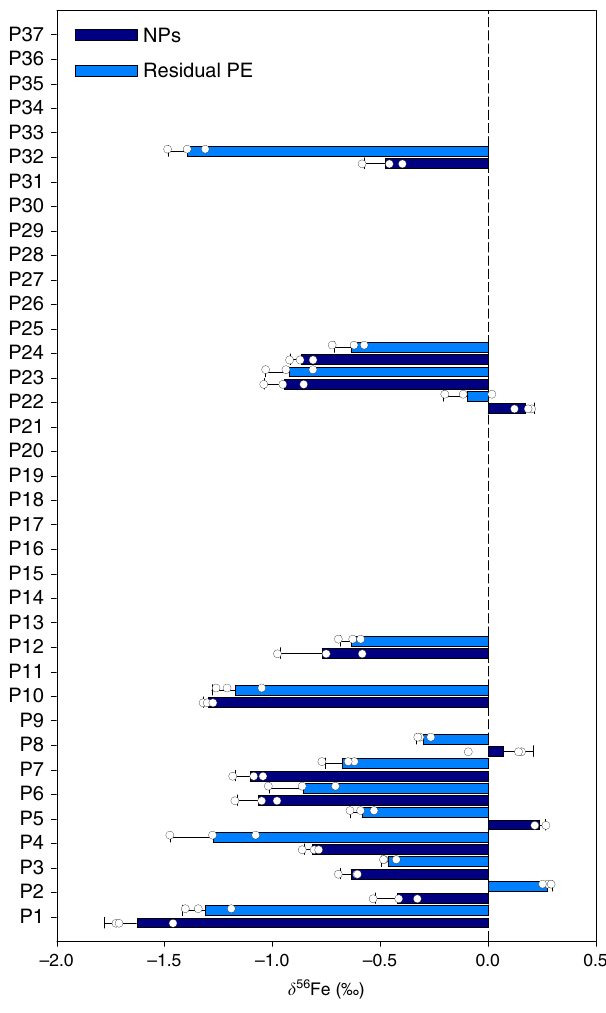
Fig. 4 Stable Fe isotopic fi ngerprints of human PE samples and the NPs extracted from the PE samples. The dark blue and light blue bars represent the NPs extracted from the PE samples and the corresponding residual PE samples without NPs, respectively. The error bars represent 1 s.d. from the isotopic ratio measurements ( n = 3). The samples with no data mean that the Fe concentrations in these samples are too low to perform the isotopic analysis. Source data are provided as a Source Data fi